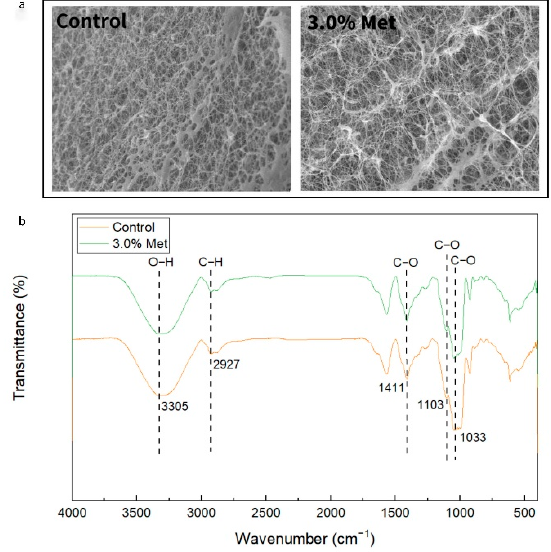
Figure 4. SEM images ( a ) and FTIR spectrogram ( b ) of BC membranes. The working distances of SEM images for the control and 3.0% Met samples were 16.8 mm and 17.2 mm, respectively, under 2.7k× magnification and with a scale of 10 μ m. The acceleration voltage was 10.0 kV. Control: the BC membrane obtained in the FCW medium; 3.0% Met: the BC membrane obtained in the FCW medium with the addition of 3.0% methionine.